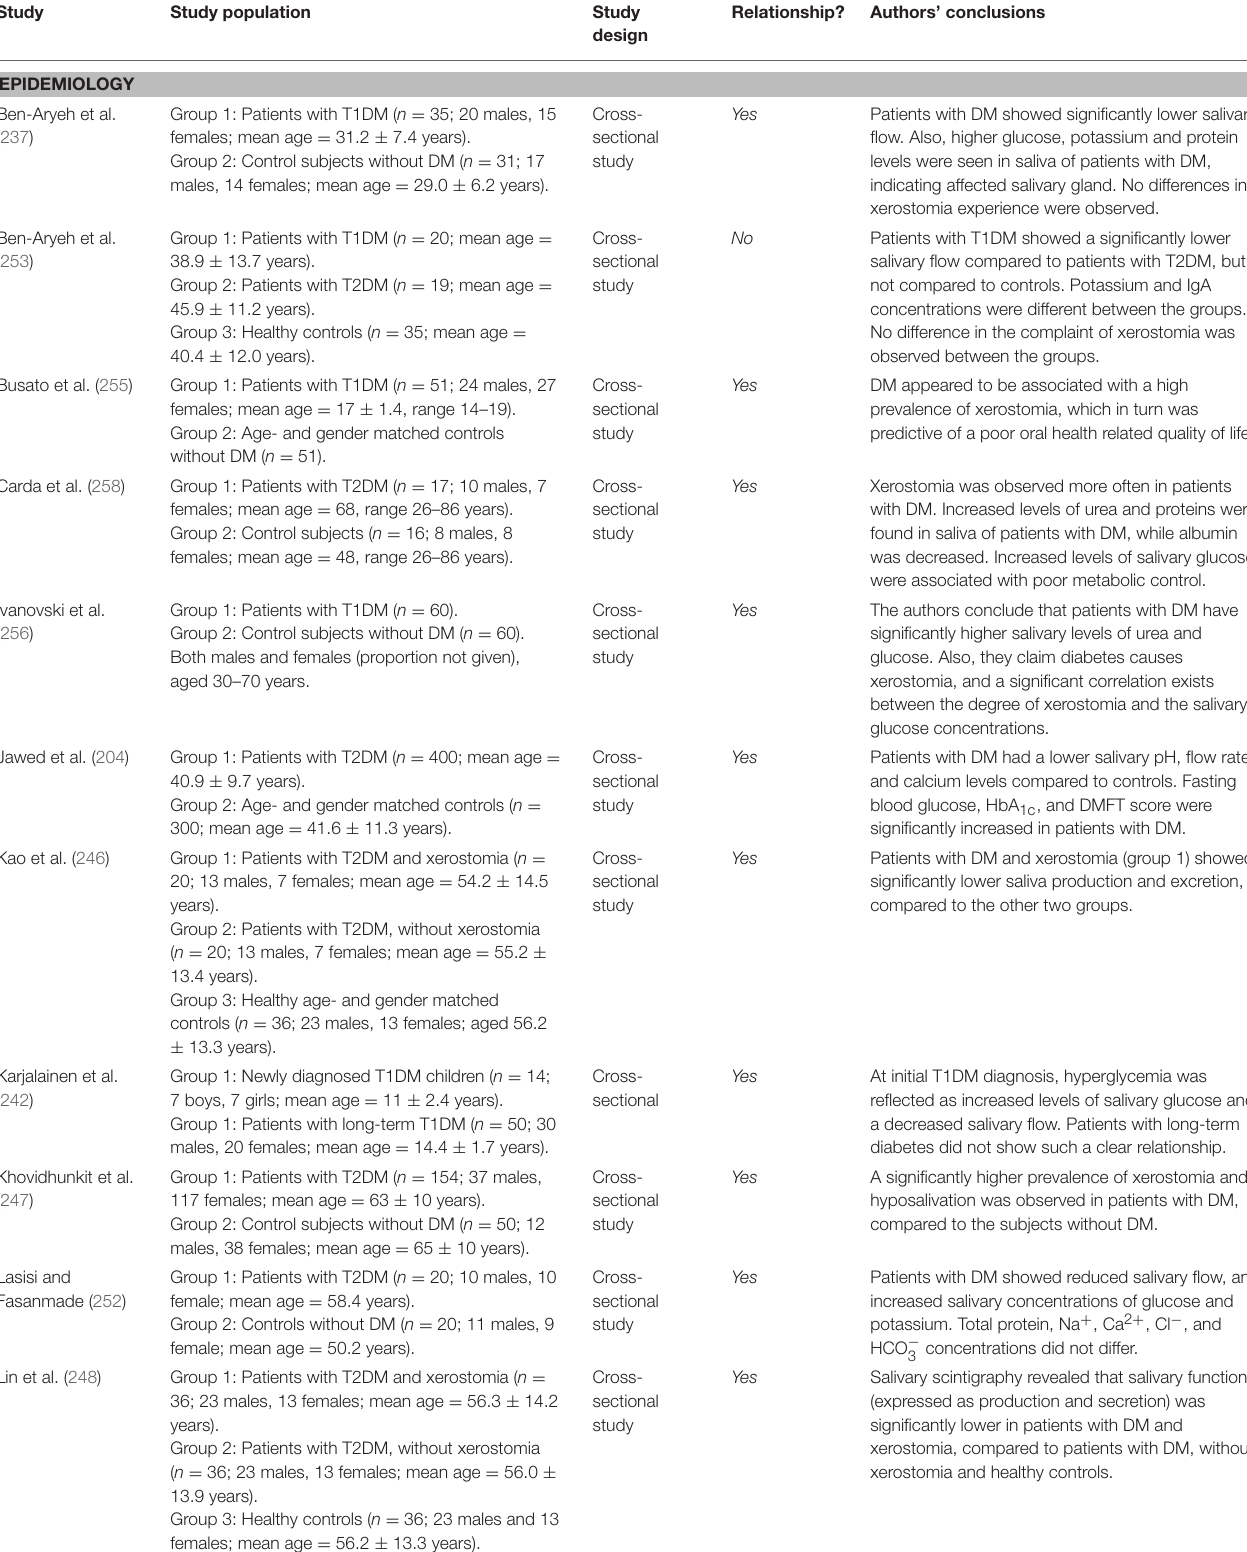
TABLE 3 | Overview of studies investigating the association between diabetes mellitus and dry mouth. Study Study population Study EPIDEMIOLOGY